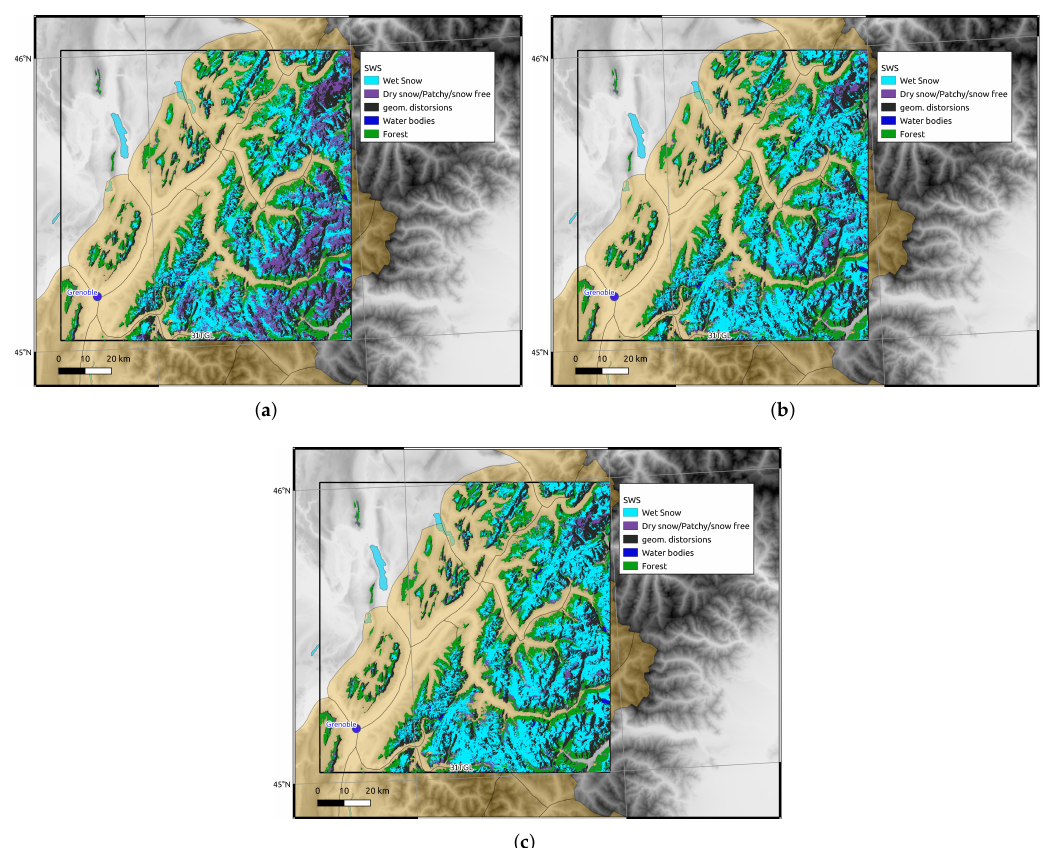
Figure 4. Maps of SWS Sentinel-1 wet snow products from the descending orbit D139 as of ( a ) 15 April 2018 ( b ) 21 April 2018 and ( c ) 27 April